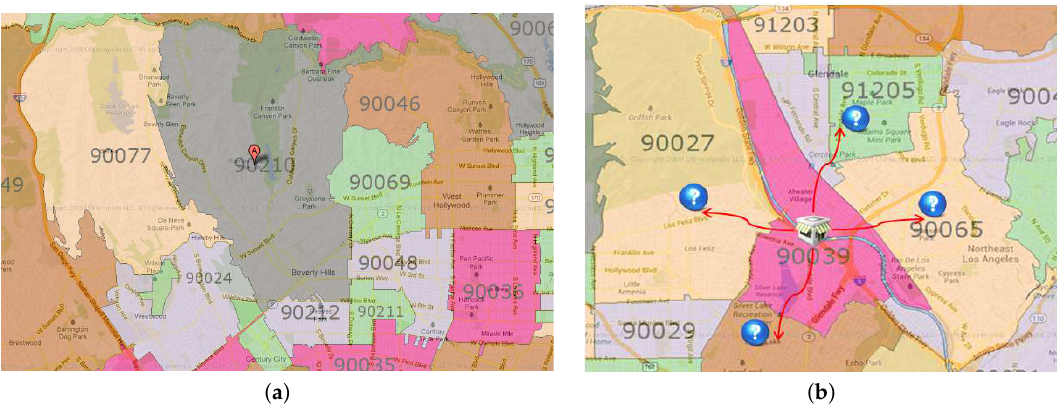
Figure 1. ZIP code data and their application. ( a ) ZIP code information; ( b ) targeted marketing